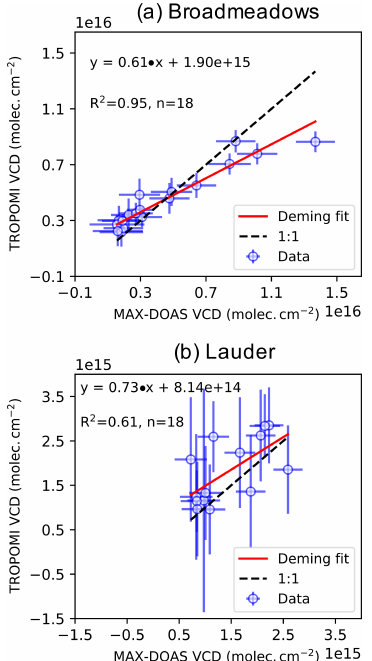
Figure 9. Scatter plot and Deming regression results for the com- parison of monthly mean formaldehyde columns from TROPOMI and the MAX-DOAS (convolved with TROPOMI averaging ker- nels) between May 2018 and November 2019 at (a) Broadmeadows and (b)